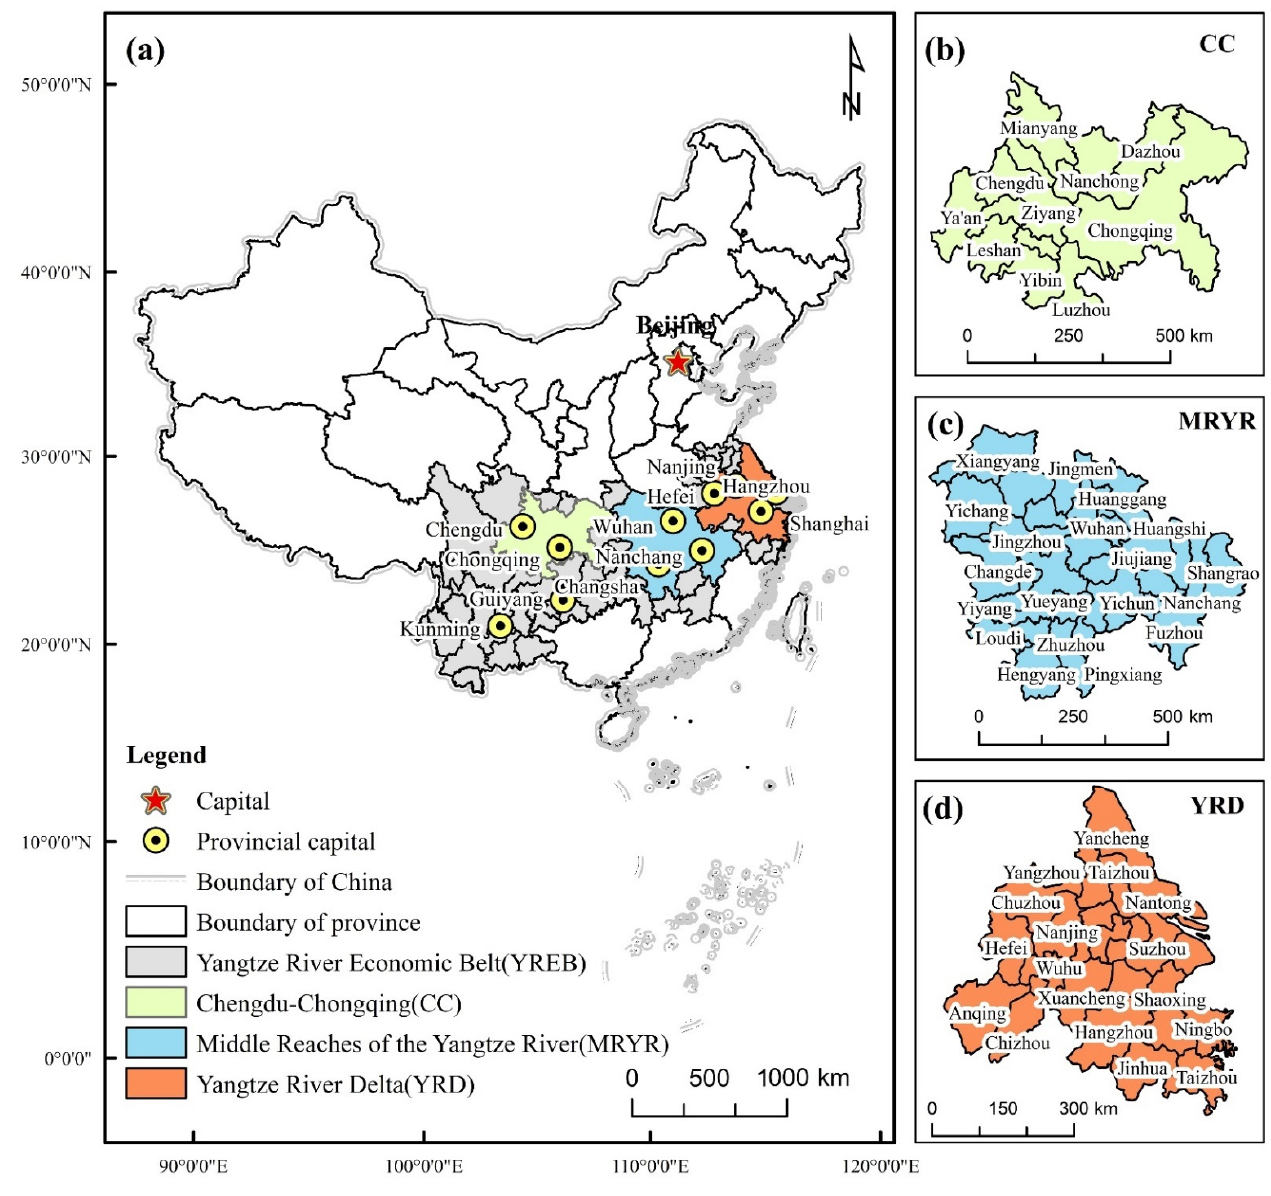
Figure 1. The location and boundaries of ( a ) the YREB, ( b ) CC, ( c ) the MRYR, and ( d ) the